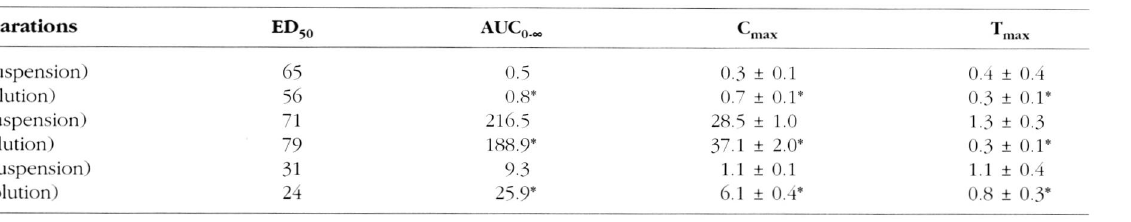
Table I. - Correlation between in vivo pharmacokinetical parameters and drug activities (ED 50 ) against Echinococcus granulosus cysts in mice. The asterisk denotes that correlation is statistically significant (p <